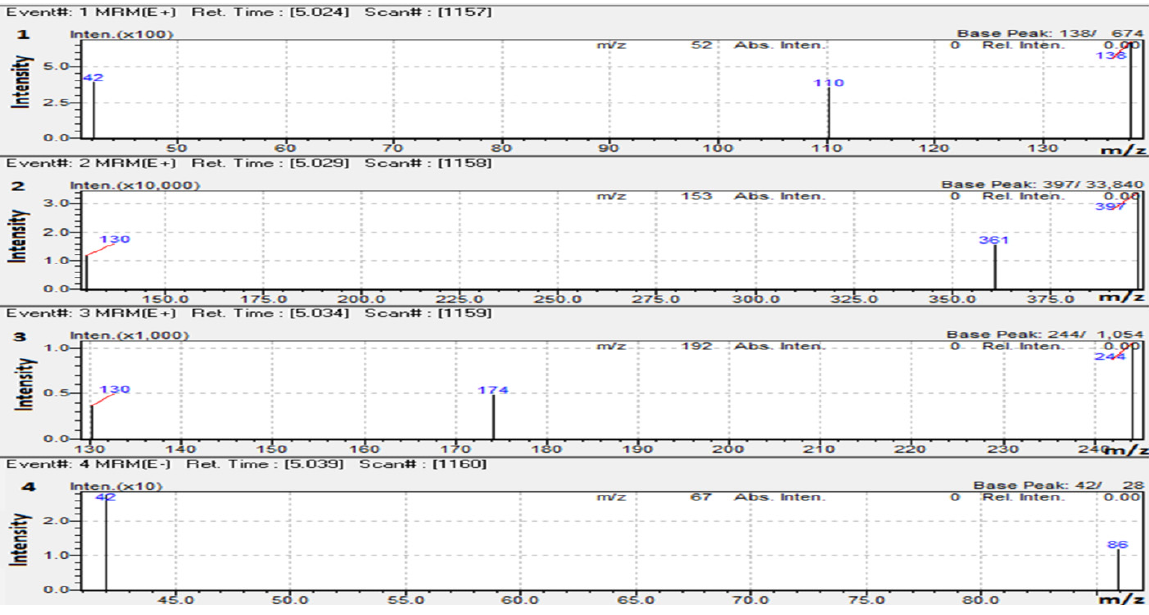
Figure 4. Product ion mass spectra of ( 1 ). (50 ng/mL) Caffeine, ( 2 ). (100 ng/mL) Doxorubicin, ( 3 ). (20 ng/mL) Capecitabine, and ( 4 ). (200 ng/mL) 5-Fluorouracil.